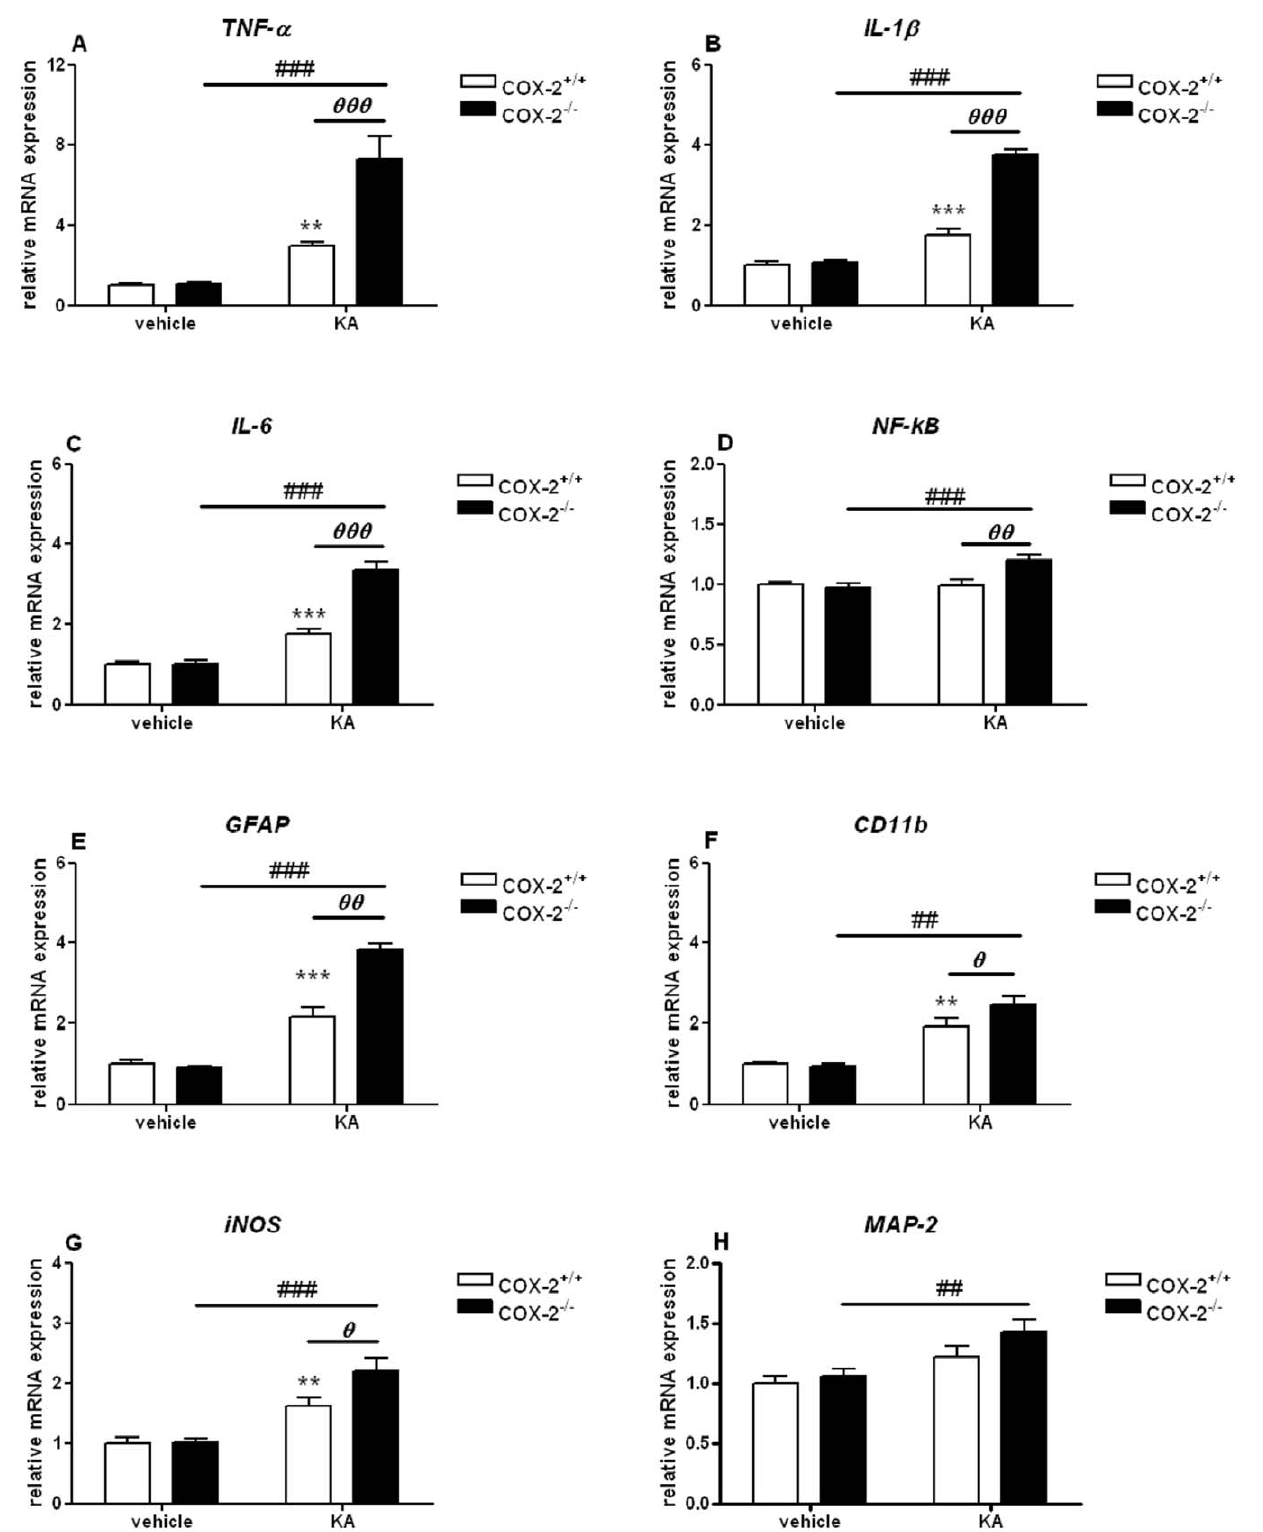
Figure 11. KA-induced expression of genes involved in the neuroinflammatory response in the hippocampus of COX-2 + / + and COX- 2 2 / 2 mice. Quantitative real time-PCR analysis of TNF- a (A), IL-1 b (B), IL-6 (C), NF-kB (D), GFAP (E), CD11b (F), iNOS (G), MAP-2 (H) for COX-2 + / + and COX-2 2 / 2 mice 24 h after i.p. injection of KA or vehicle. Data are means 6 SEM ( n =9). Statistical analysis was performed using a two-way ANOVA and Bonferroni’s post-hoc test to compare replicate means. *P , 0.05, **P , 0.01, *** P , 0.001 compared to vehicle-injected COX-2 + / + mice; # P , 0.05, ## P , 0.01, ### P , 0.001, compared to vehicle-injected COX-2 2 / 2 mice; fi P , 0.05, fifi P , 0.01, fififi P , 0.001 between KA-injected COX-2 2 / 2 and KA-injected WT mice. doi:10.1371/journal.pone.0019398.g011 PLoS ONE |